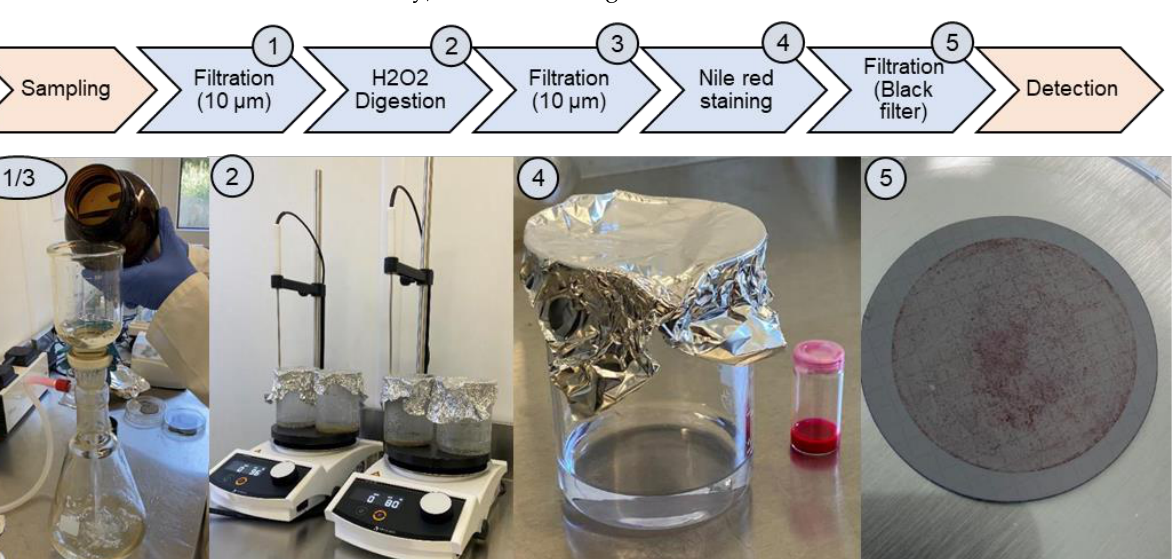
Figure 2. Setup for sampling microplastics in water bodies.